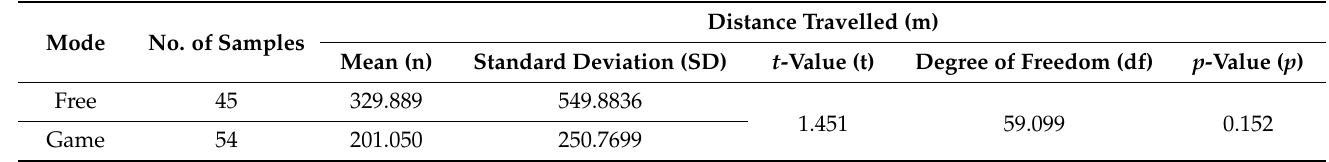
Table 2. Summary table of t -test of exhibition-viewing distance travelled.